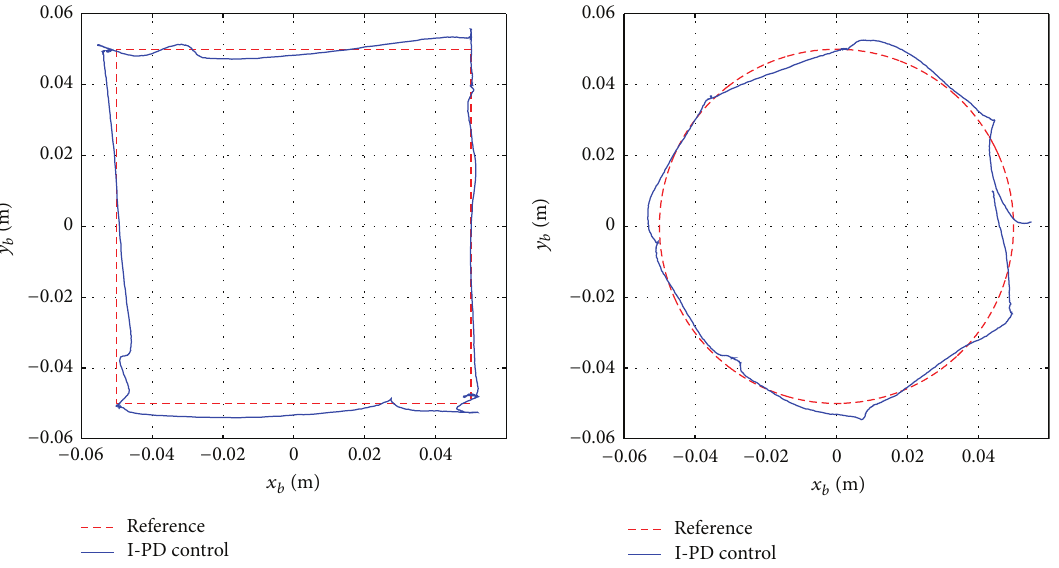
Figure 11: Experimental results of tracking control.